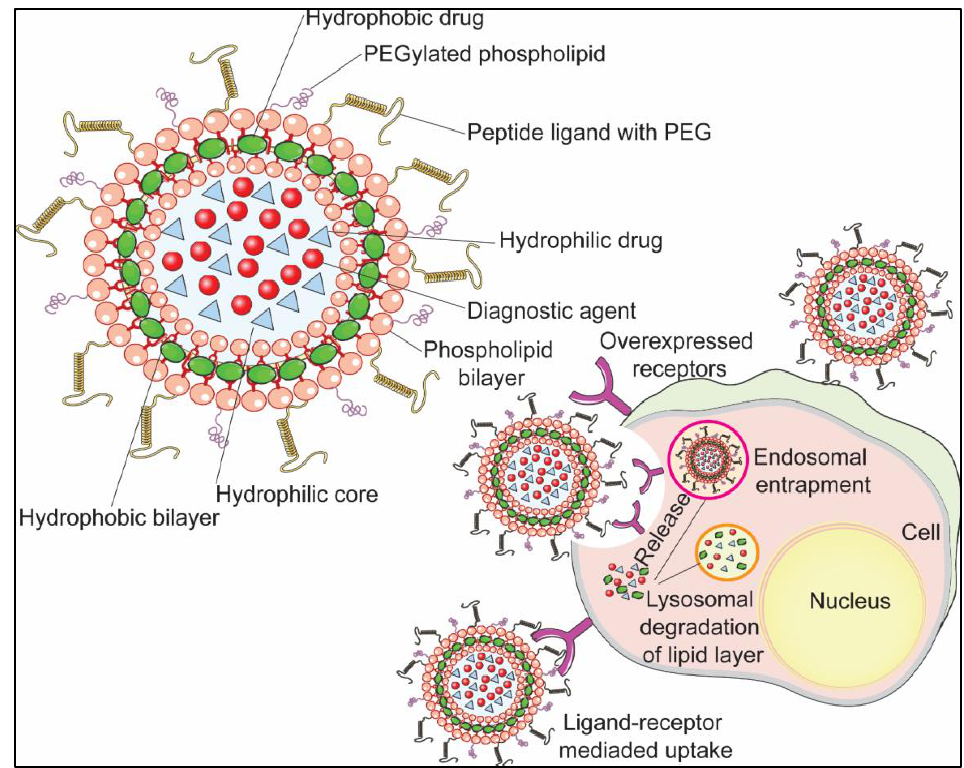
Figure 2. Schematic illustration showing the peptide-functionalized liposomal NDS acting on receptors overexpressed on the surface of cancer cells via targeted delivery. The peptide conjugated to the NDS binds specifically to the receptors upregulated on the surface of cancer cells, which is followed by its uptake by the cancer cells through receptor-mediated endocytosis. Subsequently, the payload of the NDS is released by the degradation of the lipid bilayer via the endosomal–lysosomal pathway.